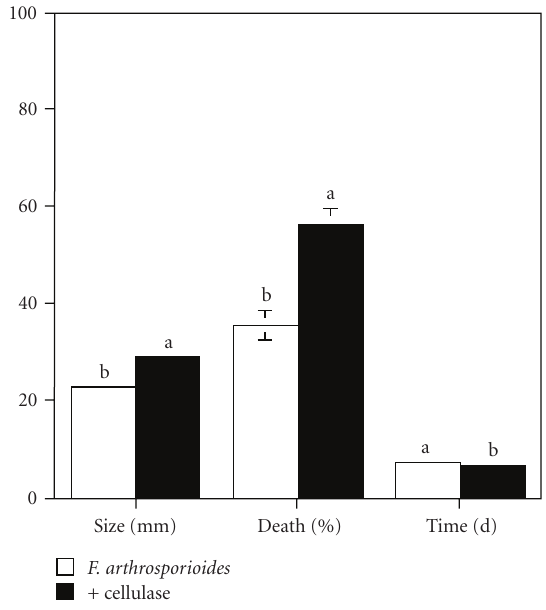
Figure 1: Tubercle size, corresponding percentage death, and number of days to death as observed for F. arthrosporioides (7 × 10 6 propagules ml − 1 ) (cid:2) and F. arthrosporioides plus 20 Uml − 1 cellulase (cid:3) . Data represent means ± standard error for 278 replicate for F. arthrosporioides (cid:2) and 282 for F. arthrosporioides plus 20Uml − 1 cellulase (cid:3) . Tubercle size, % death, and the time means with di ff erent letters among treatments are significantly di ff erent according to Fisher’s LSD test.